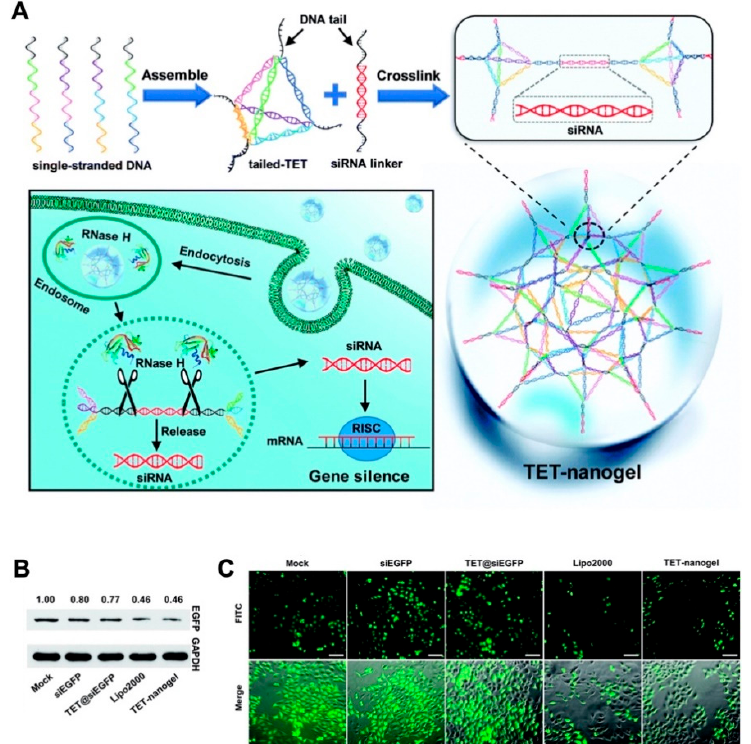
Figure 8. ( A ) The scheme for preparation of TET-nanogel and mechanism for the intracellular delivery of siRNA by crosslinking strategy; ( B ) Western blot analysis of EGFP expression by different vectors; ( C ) fluorescence microscopy images of gene silencing levels. Republished with permission of Royal